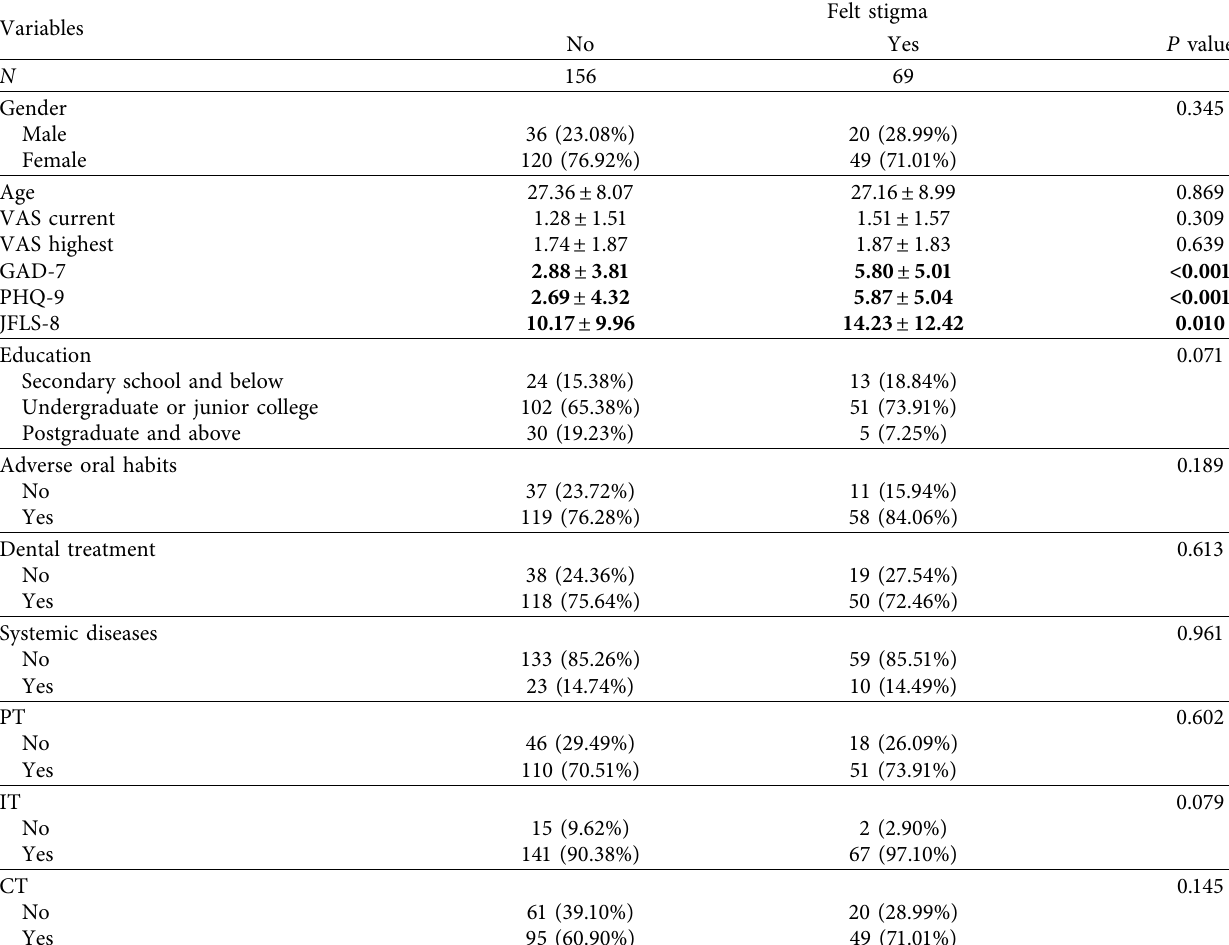
Table 3: Effects of clinical characteristics and quantitative variables on felt